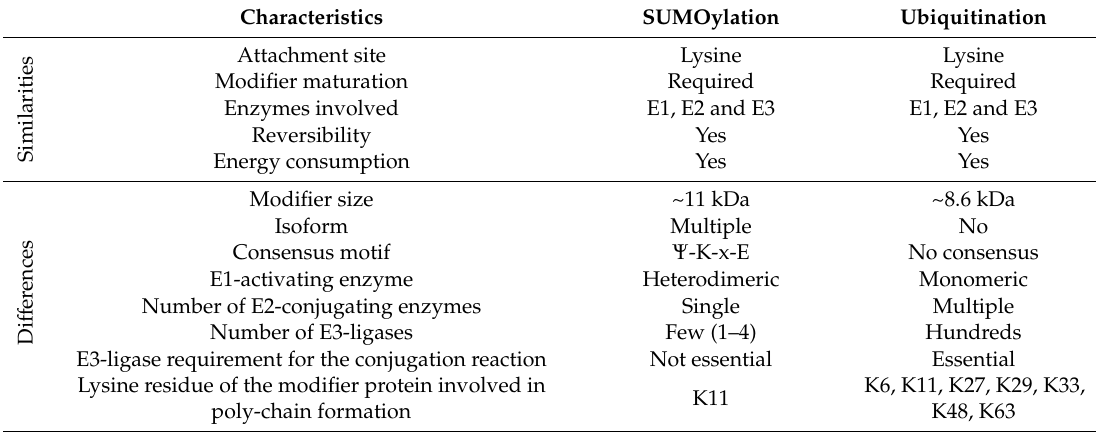
Table 1. A comparison of SUMOylation and ubiquitination #